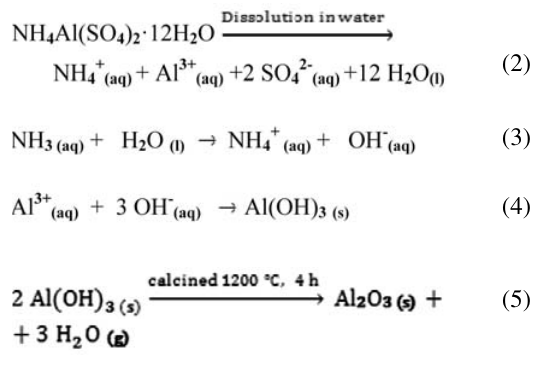
O NPs; (b) Al 2 3 O NPs modified by TMVS.